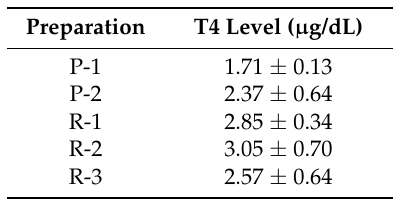
Table 3. T4 levels obtained in in vivo bioassays ( N = 10 mice) after administration of the different hTSH preparations.